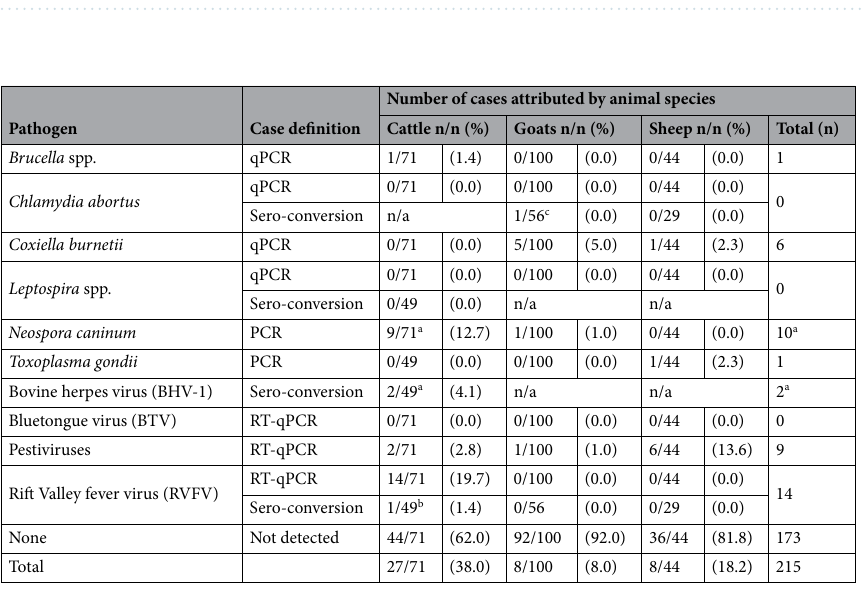
Table 2. Number of abortion cases (cattle, goats and sheep) attributed to abortigenic agents using study case definitions, northern Tanzania 2017–2019. a One case in a cow met both BHV-1 (seroconversion) and Neospora (PCR) case definition and was thus included in both. b One case in a cow met both RT-qPCR and seroconversion case definitions for RVFV and was thus included in both. c Seroconversion was observed in one goat with a qPCR-negative swab sample for C. abortus and therefore this case did not meet the case definition. n/a not applicable.